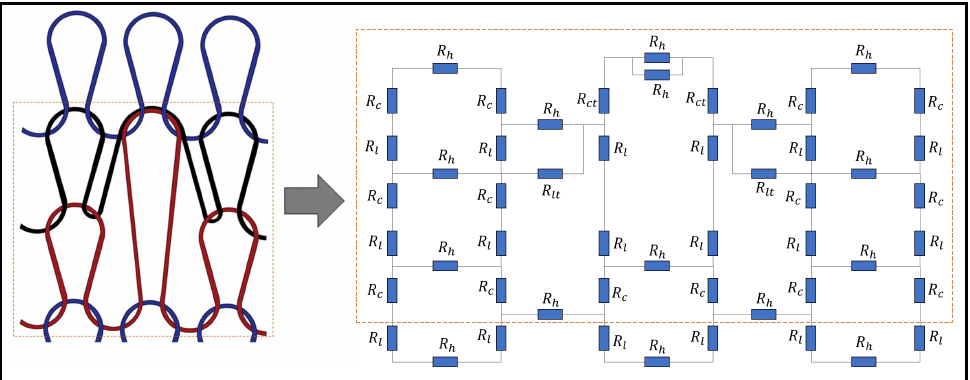
Figure 2. The resistive model of a Tuck stitch in a Weft Knit